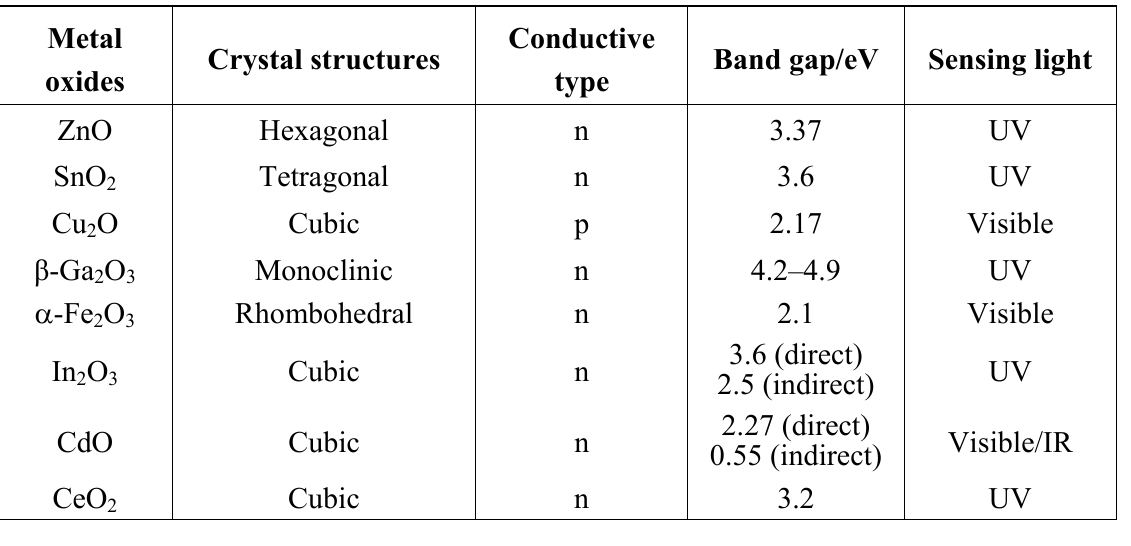
Table 1. Fundamental physical properties of some important metal-oxide